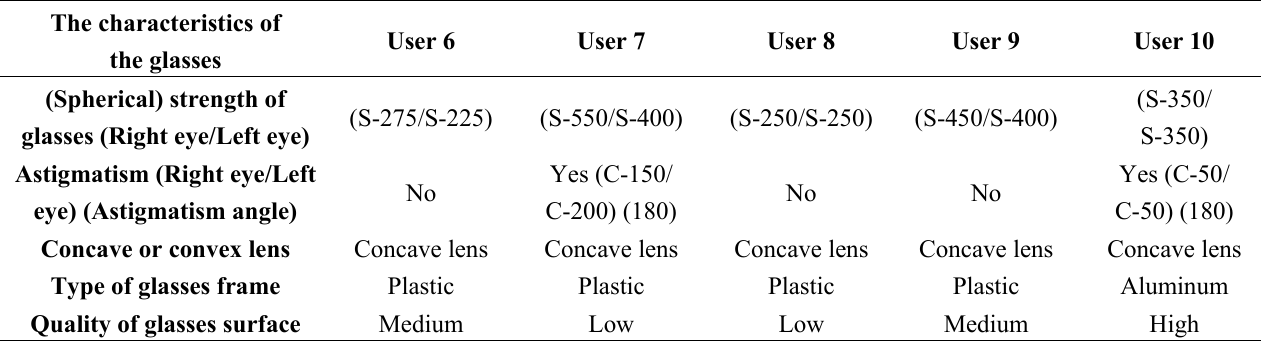
Table 2. The characteristics of the glasses for users 6–10 from Tables 1, 2, 4, 6, 8 and 10. The characteristics of